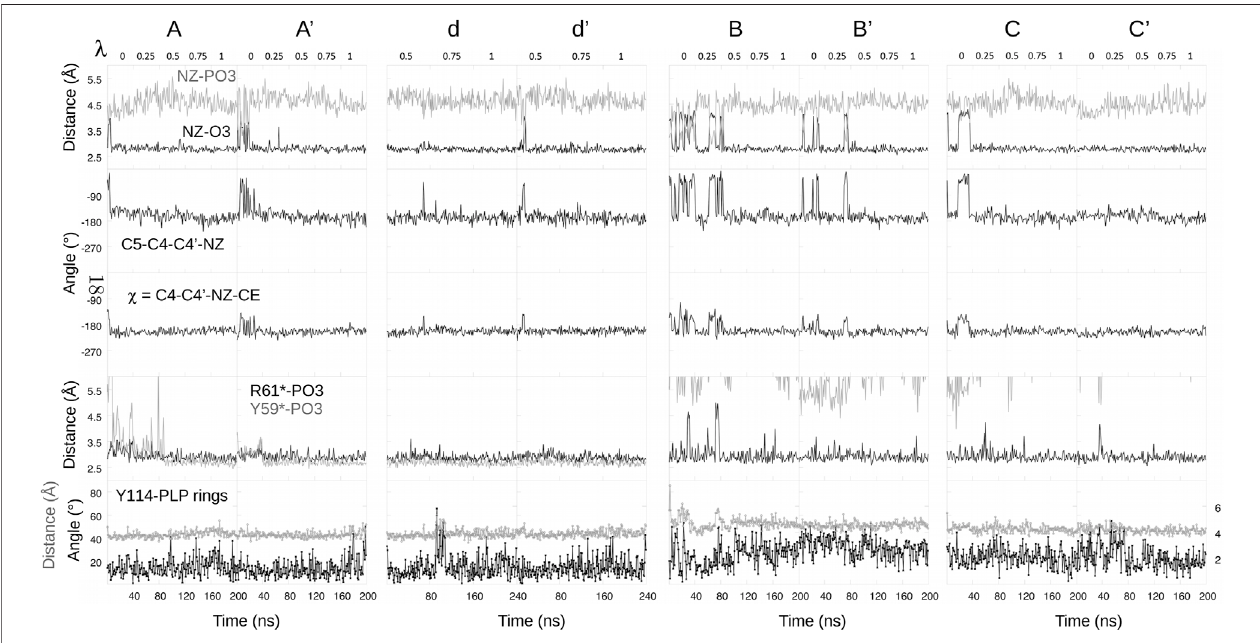
FIGURE 6 | Selected structural variables seen during FEP. Headings above each column indicate free energy runs.